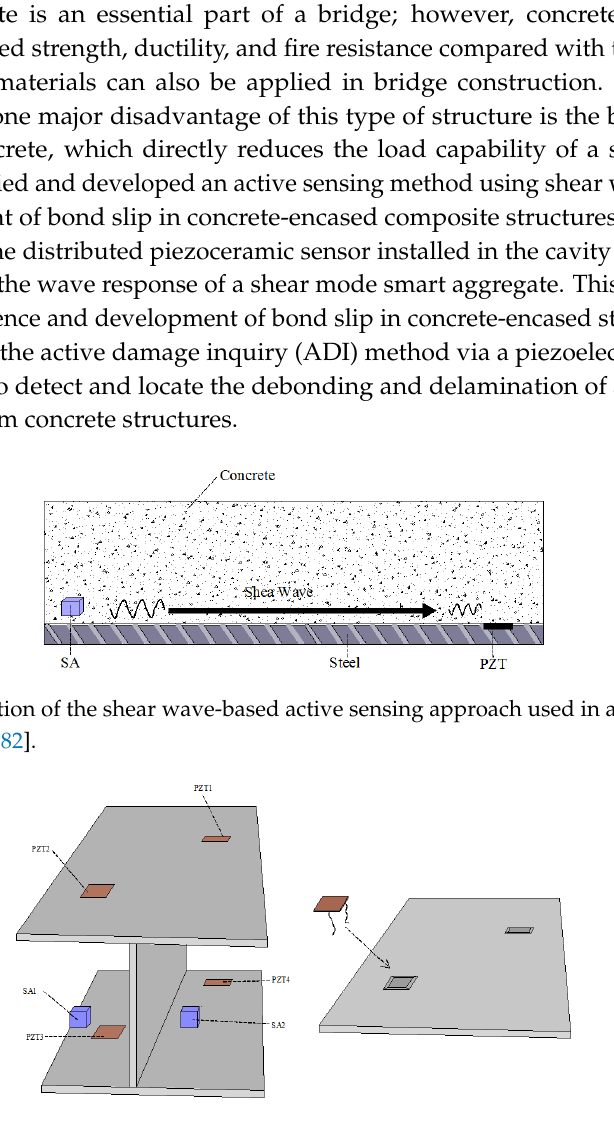
Figure 6. Installation of PZT sensors [82].